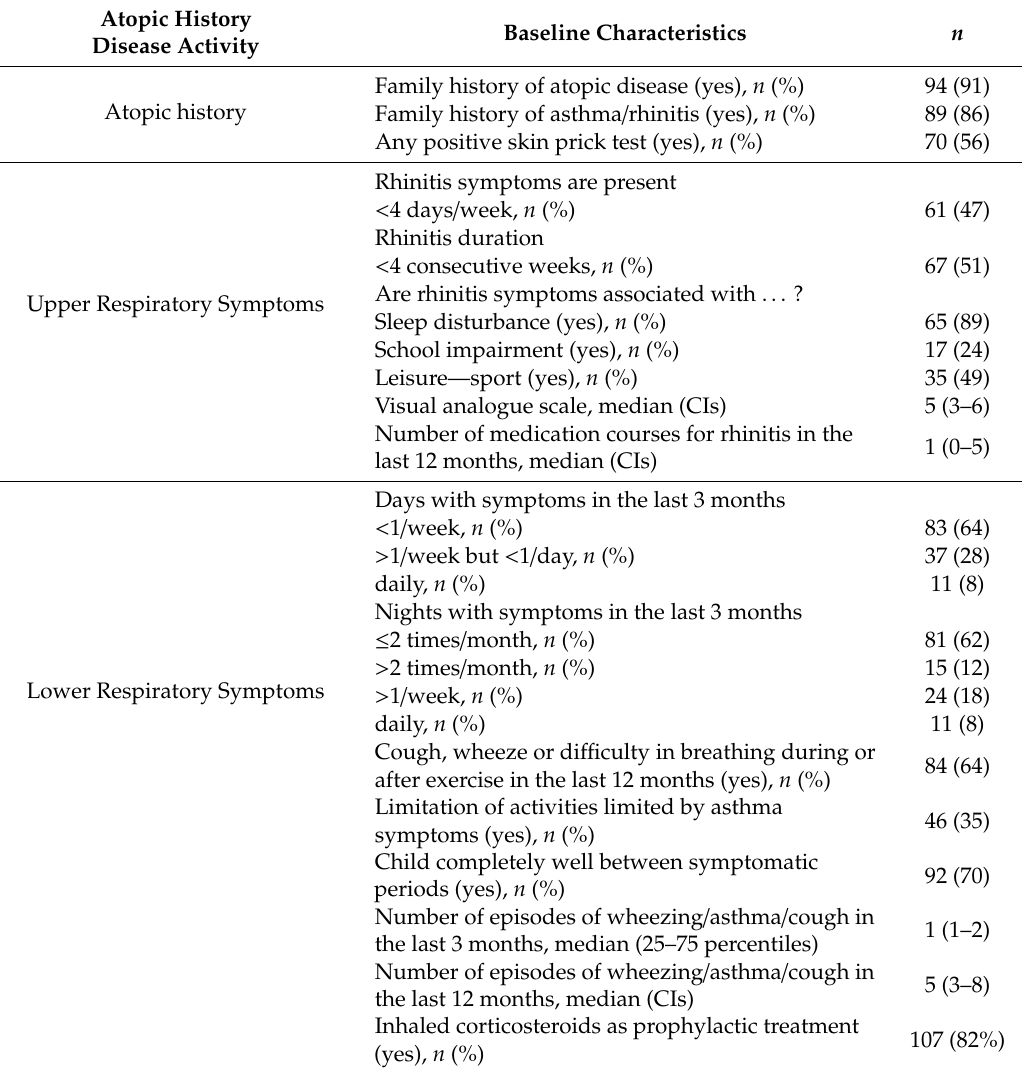
Table 1. Baseline characteristics regarding disease activity and atopic history of the asthmatic